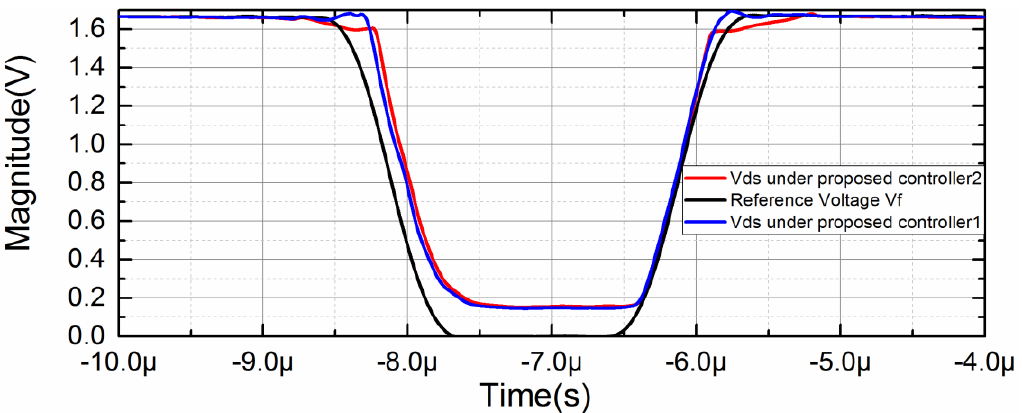
Figure 15. Experiment result that voltage comparison V ds of proposed controller 1 (blue, t off = t fall = 1 µ s of V f ), proposed controller 2 (red, t off = t fall = 1 µ s of V f ), and reference voltage V f (black, t off = t fall = 1 µ s).